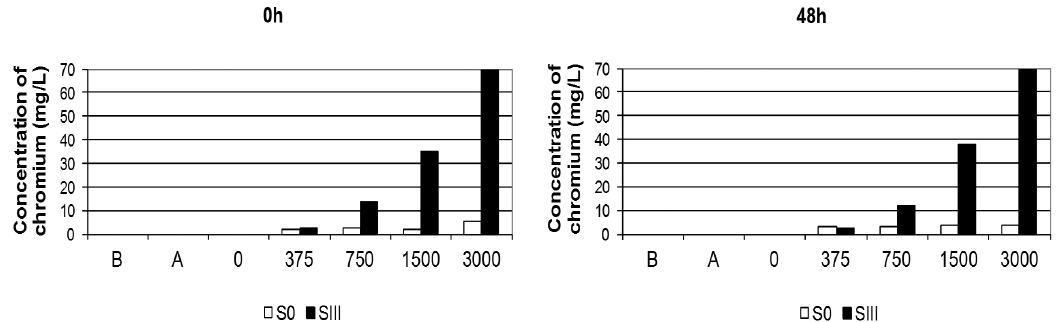
Figure 4. Chromium concentration in the water at the beginning (0h) and end (486h) of the tests with artificial sediment in D. rerio and P. reticulata with (SIII) and without organic matter (S0). A: treatment with sand without contamination by chromium; B: blank (reconstituted